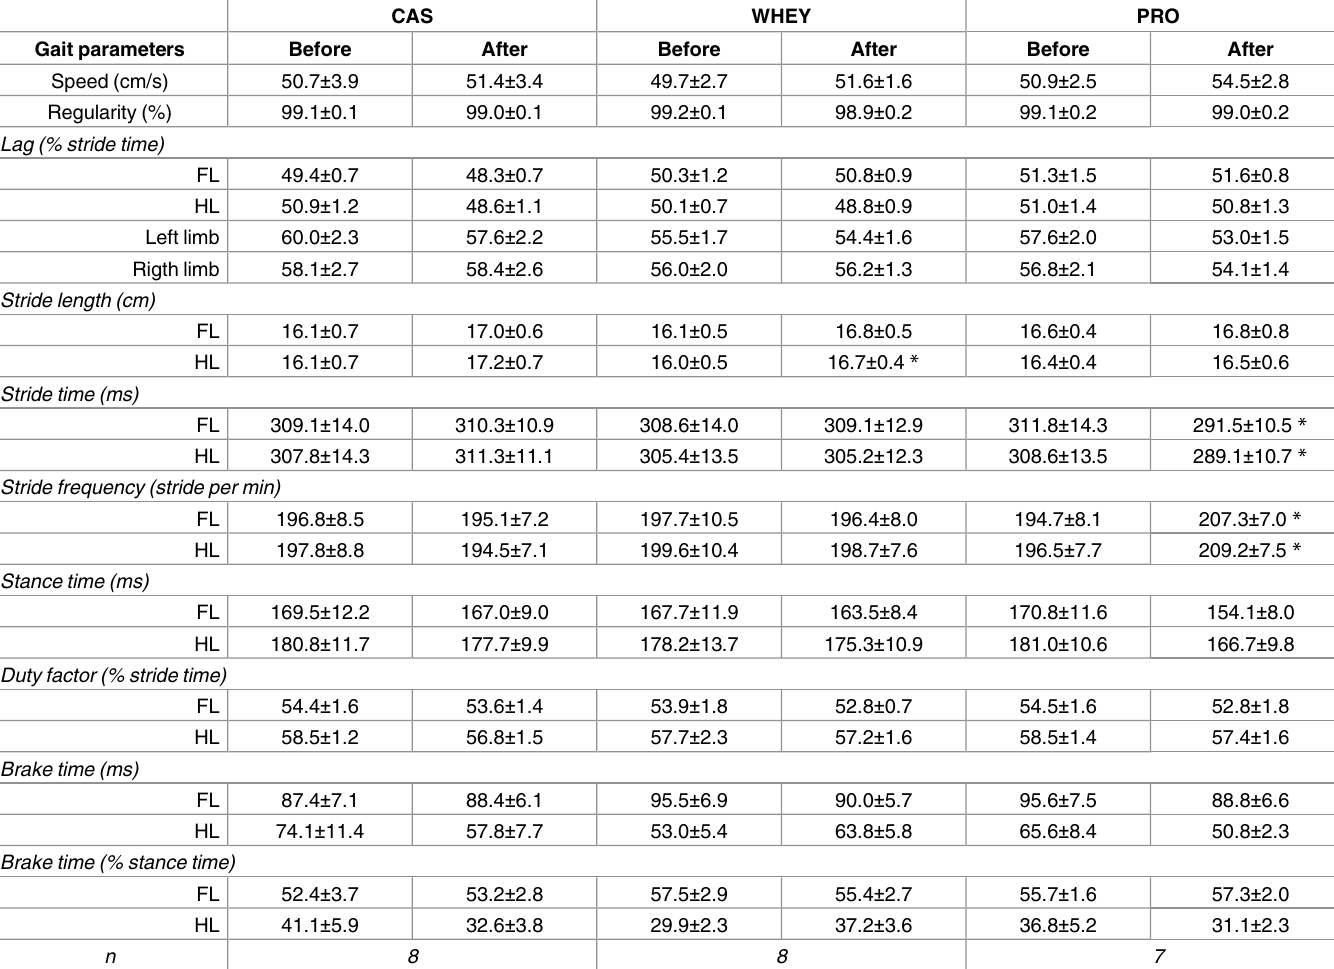
Table 7. Stride frequencies increasein old sedentaryrats with soluble milk protein supplementation. CAS WHEY